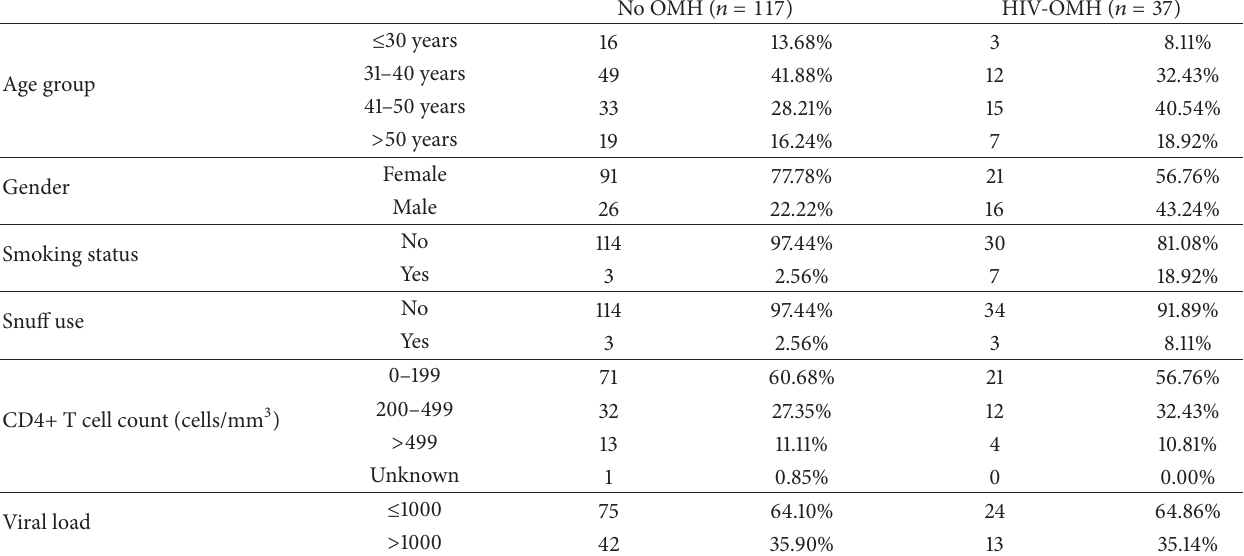
Table 1: Demographic and immunological characteristics of the study population; all subjects were Black.